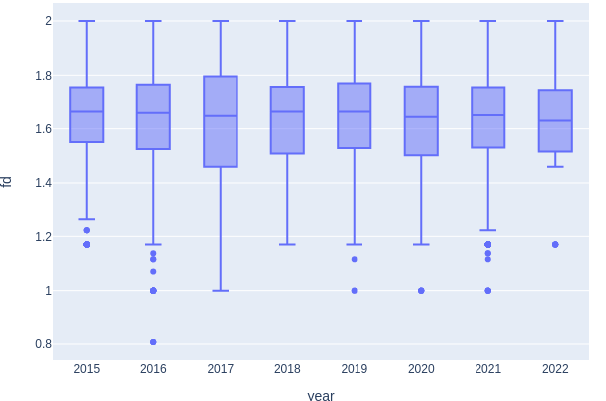
Figure 7. Box plot of the fractal dimension (fd) for the time period 2015–2022; the studied region is in